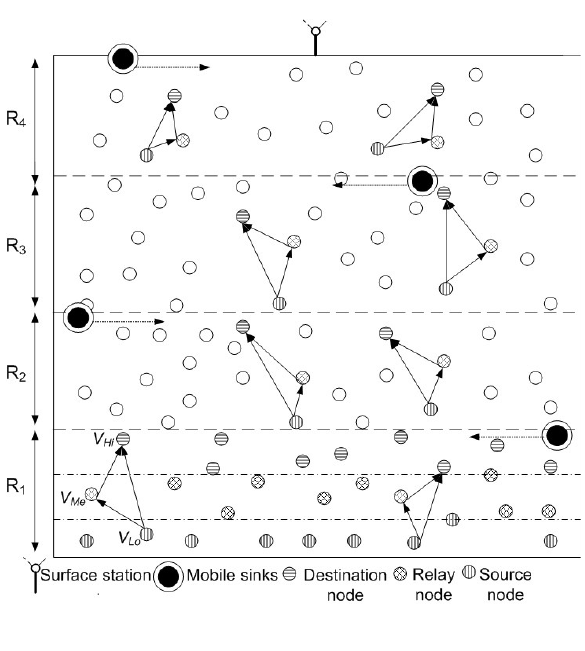
Figure 1. Network